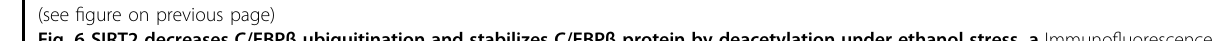
mutants reversed SIRT2 de fi ciency-aggravated alcoholic liver injury, including elevated liver to body weight ratio (Fig. 7b), TG accumulation (Fig. 7c), lipid peroxidation (Fig. 7a, d, e), serum ALT and AST level (Fig. 7f, g), and hepatocyte apoptosis (Fig. 7a, h, j). However, wild-type C/ EBP β had no effect on the enhancement of the lipid peroxidation (Fig. 7a, d, e) and hepatocyte apoptosis (Fig. 7a, h, j) caused by SIRT2 deletion. Consistent with the results in AML12 cells, K102R or K211R mutant protein level was signi fi cantly higher than that of wild- type C/EBP β in SIRT2 -KO murine livers (Fig. 7j), whereas the viral infection and transcription level were similarly indicated by BLI and qRT-PCR (data not shown).